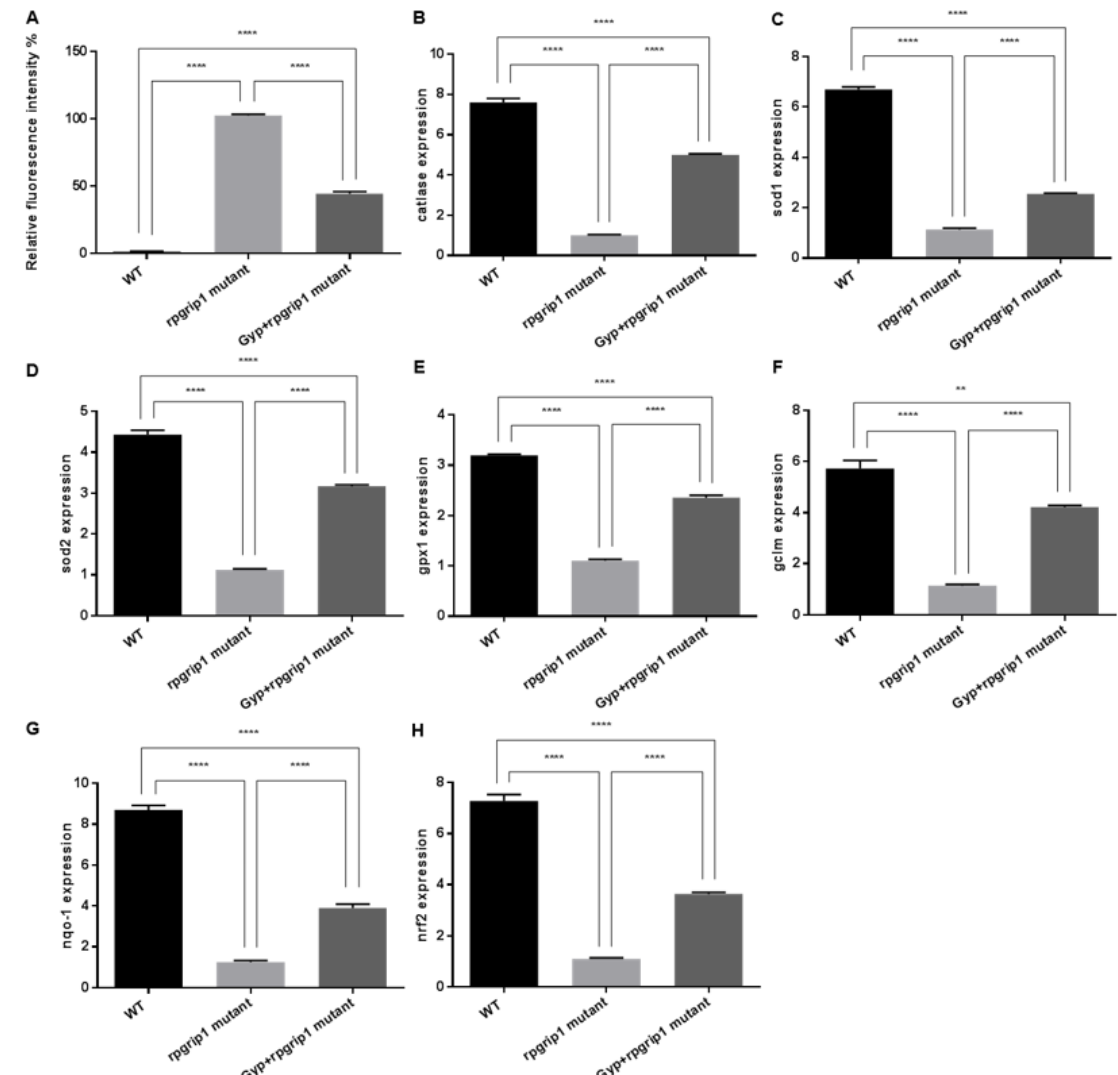
Figure 4. Effects of Gyp on antioxidant capacity in rpgrip1 mutant zebrafish eyes. ( A ) ROS generation in the eyes of wildtype (WT), untreated (UT) and Gyp-treated rpgrip1 mutant zebrafish at 6 mpf. ( B – H ) Expression of catalase , sod1 , sod2 , gpx1 , gclm , nqo-1 , gclm and nrf2 was determined using qRT-PCR. Statistical comparisons between individual groups were carried out using one-way ANOVA followed by Bonferroni’s test. Data are displayed as mean ± SEM ( n = 6 animals of each group). ** p < 0.01, **** p <